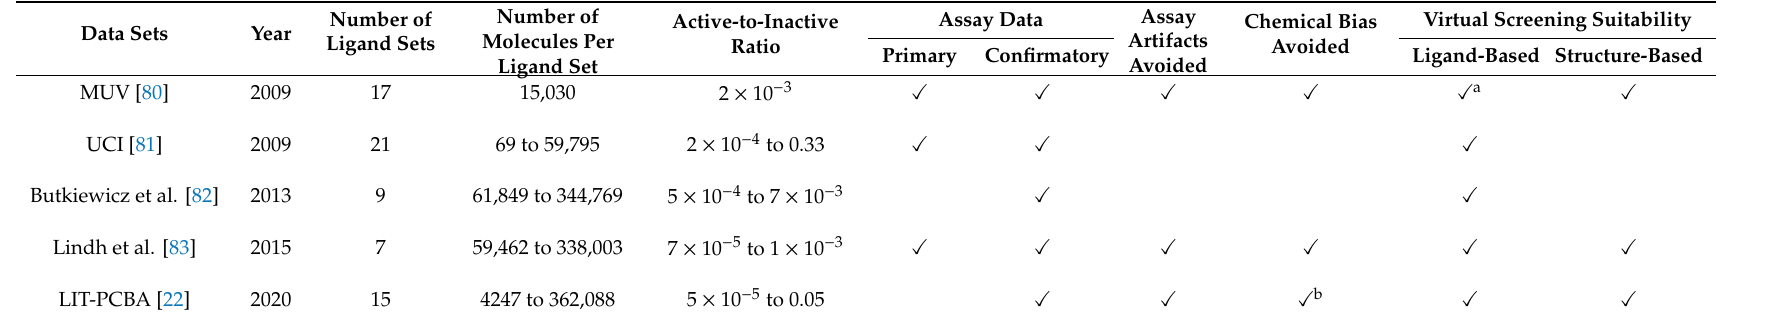
Table 1. Overview of the main open-access benchmarking data sets developed from experimental PubChem BioAssay